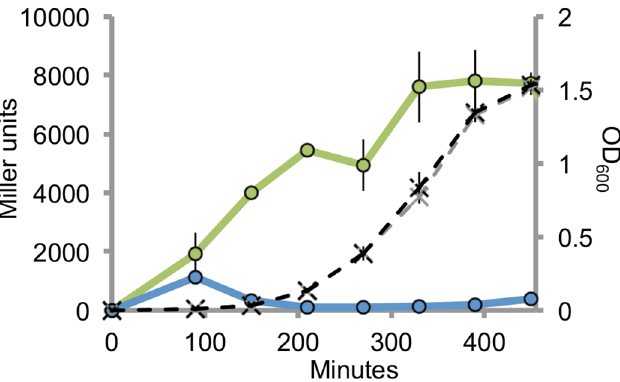
Fig 3. Transcriptional activity of promoters P mrkA[Kp] and P mrkA[P] in E. coli. β -galactosidase assays were performed after growth in LB at 37°C and samples were taken over a period of 8.5h. Growth (black) and β -galactosidase activity (blue) of β -galactosidase activity (green) of P mrkA[P] -lacZ fusion. Growth (gray) and P mrkA[Kp] -lacZ fusion (Error bars denote ± SEM, n =